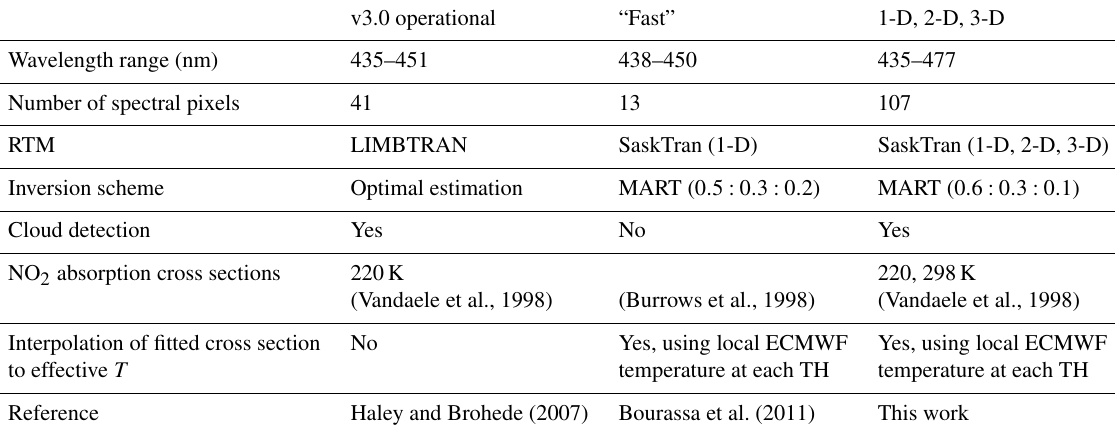
Table 1. Main features of OSIRIS NO 2 algorithms compared in this